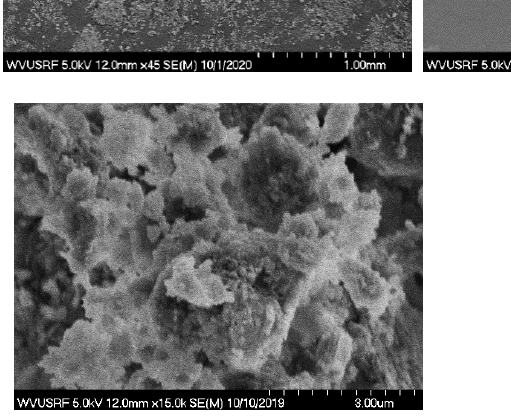
Figure 2. SEM images of the zeolite samples under various magnifications: ( A ) the coarsest sample, ( B ) middle-sized sample, ( C ) the finest sample.